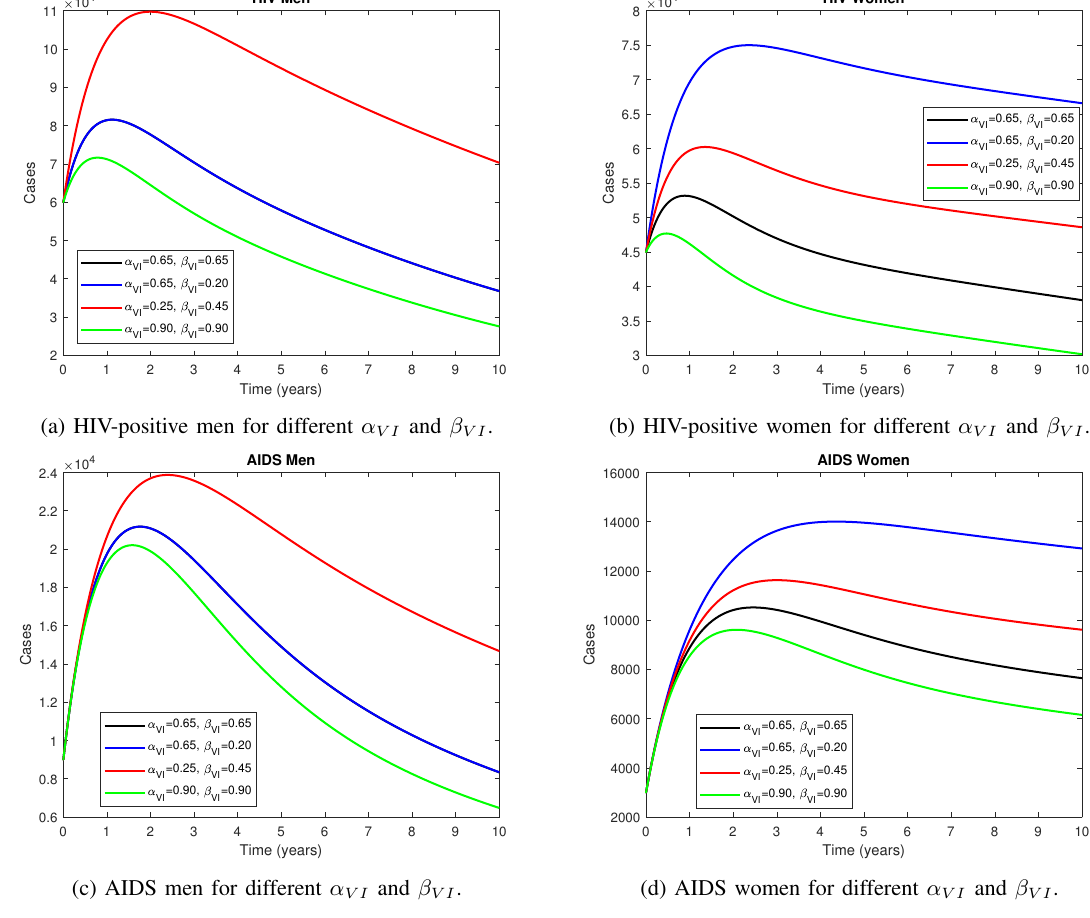
Fig. 13: Behavior of HIV, AIDS and undetectable for the joint variations of α V I and β V I .